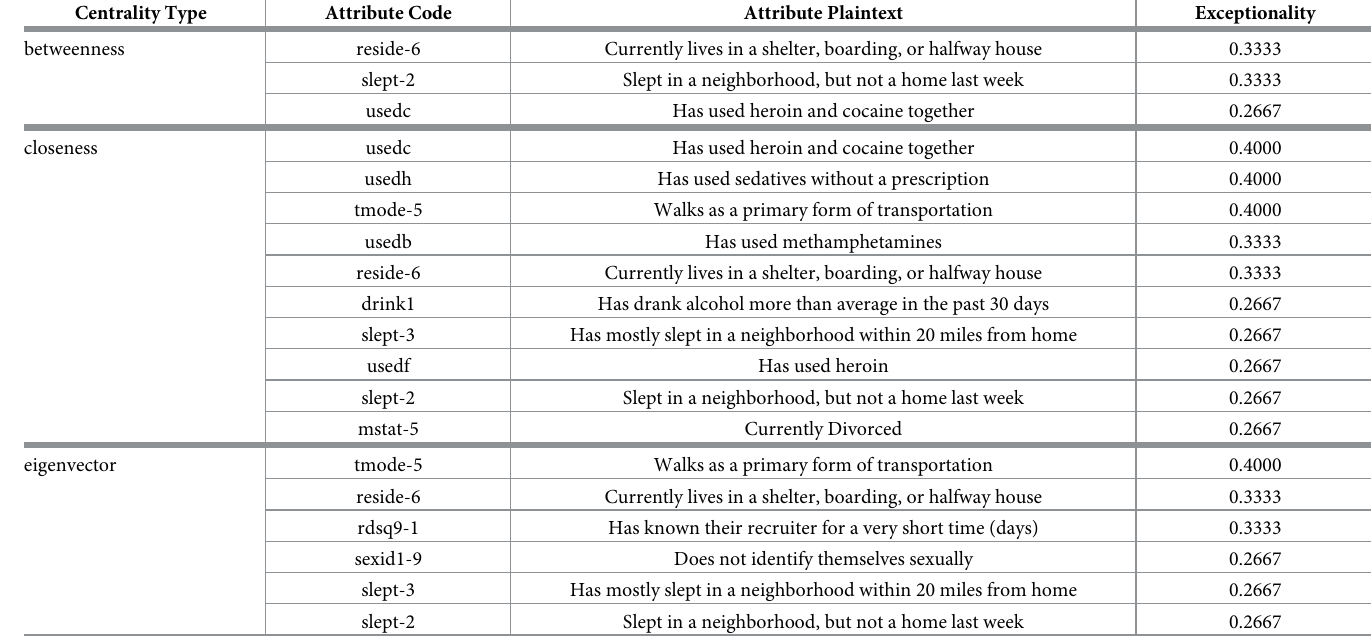
Table 3. Exceptional attributes of